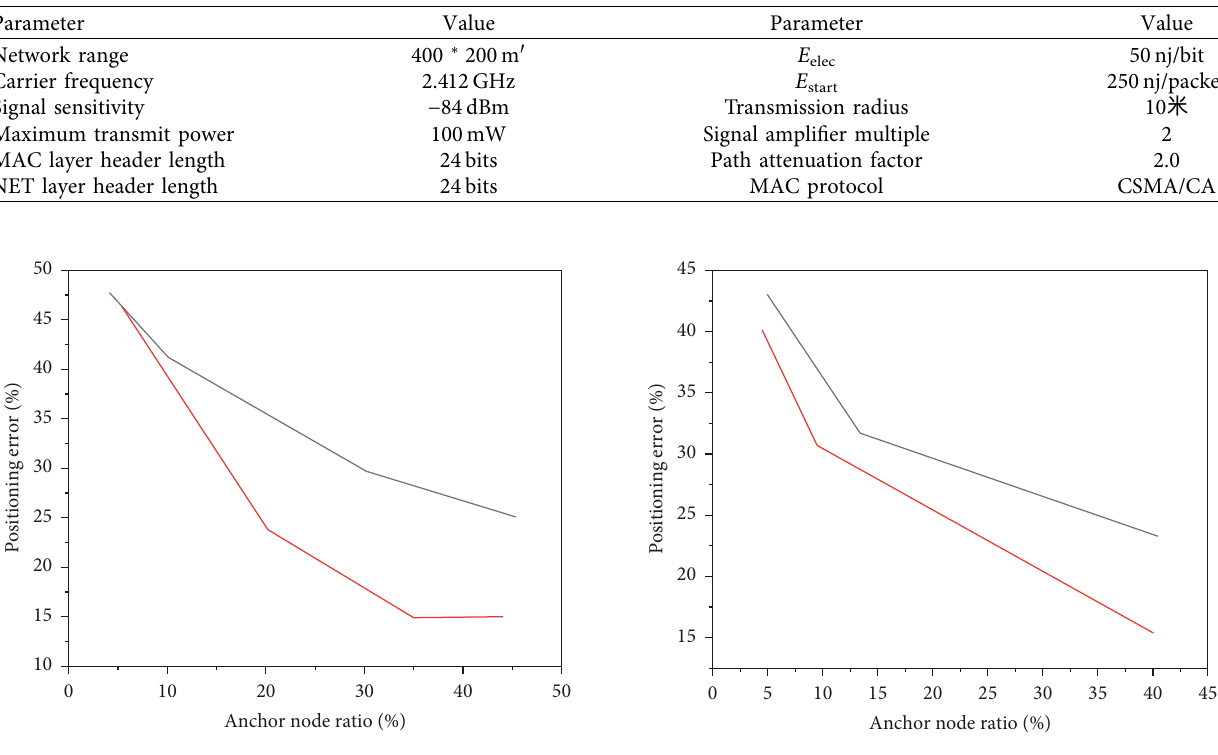
Table 3: NRSSI_Network parameters of DV-Hop algorithm